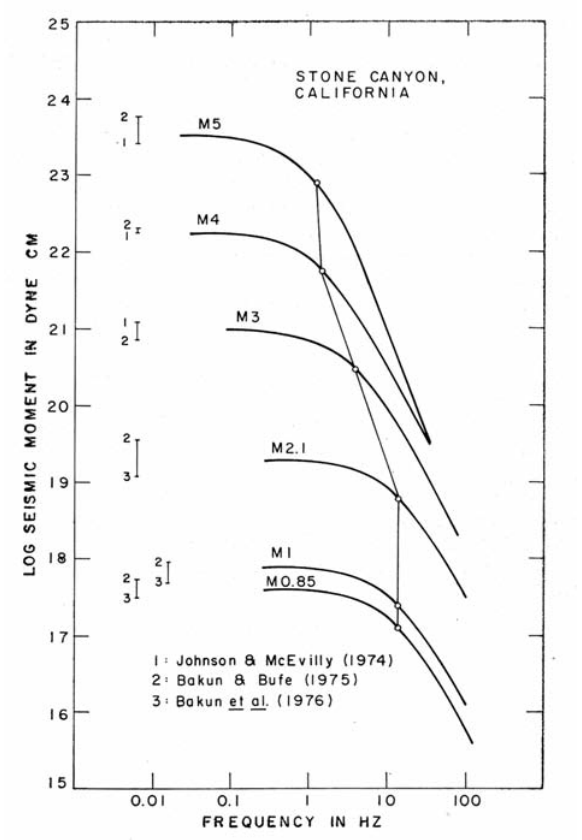
Figure 2. Comparison of the corner-frequency vs. moment relation determined by the coda method (solid line), various deterministic methods (for individual earthquakes) and extrapolation from larger earthquakes (dashed lines). Reproduced from Chouet et al.